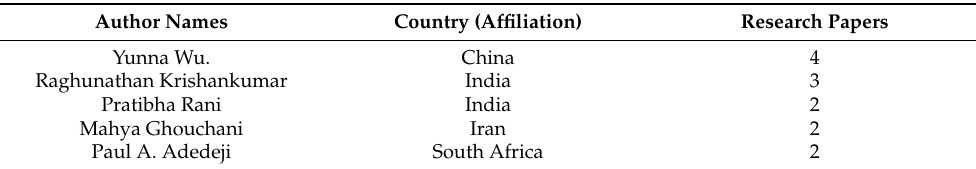
Table 5. List of first authors in the CES field who published two or more works (based on the articles collected from 2018 to 2021).